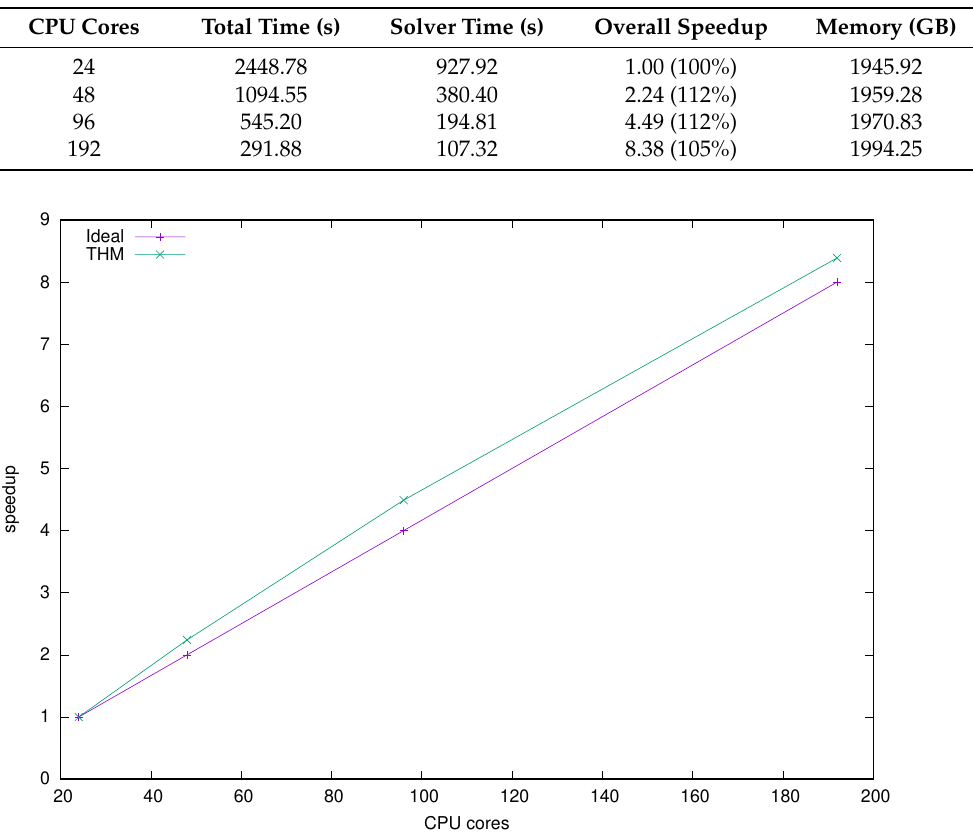
Table 13. Summary of Example 6.